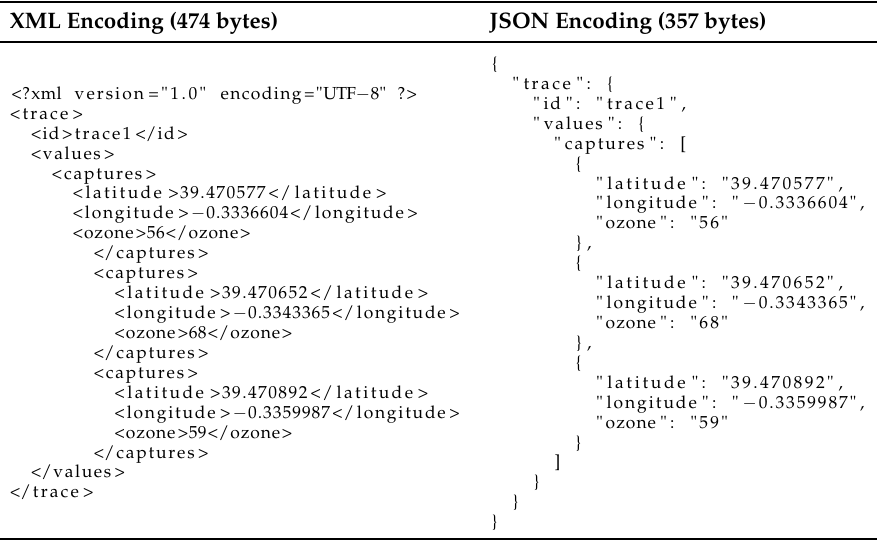
Table 1. Example of data representation using typical encoding types.